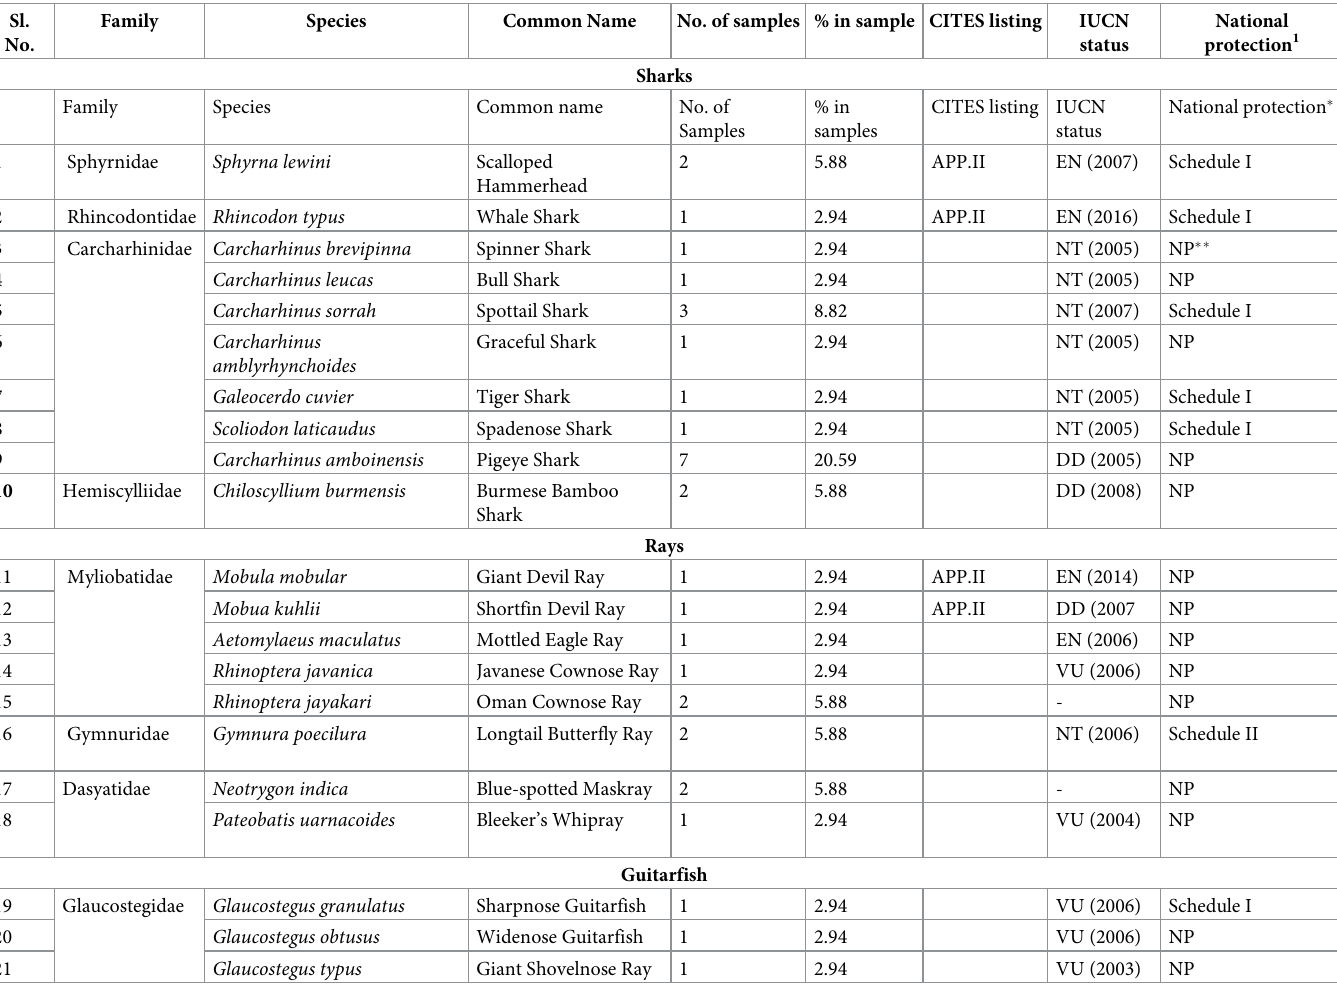
Table 1. Total number (n) and percentage of total (%) species recorded within the study from Bangladesh with their IUCN Red List status and their assessment dates including CITES listing and status in Wildlife (protection and security) Act, 2012, Bangladesh. (EN Endangered; NT Near Threatened; VU Vulnerable; DD Data Deficient; LC Least